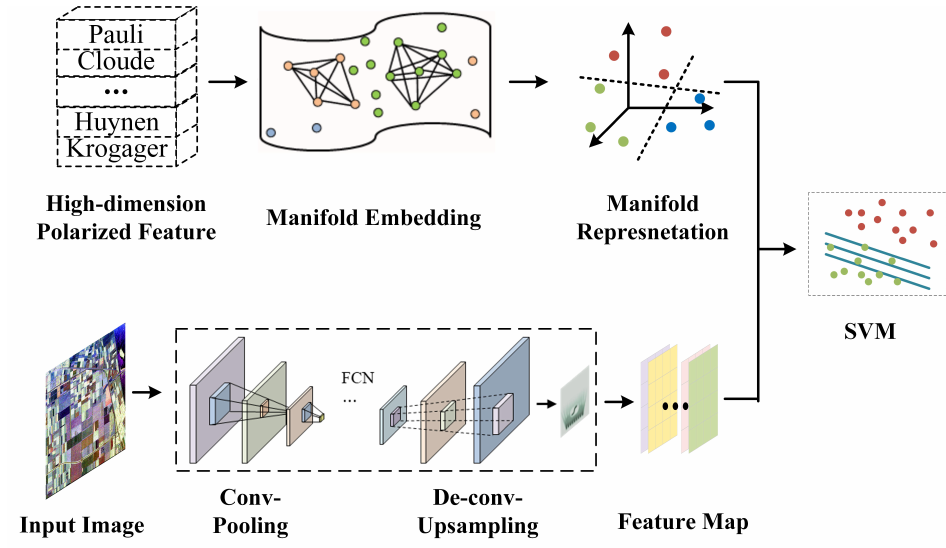
Figure 5. The framework of the proposed